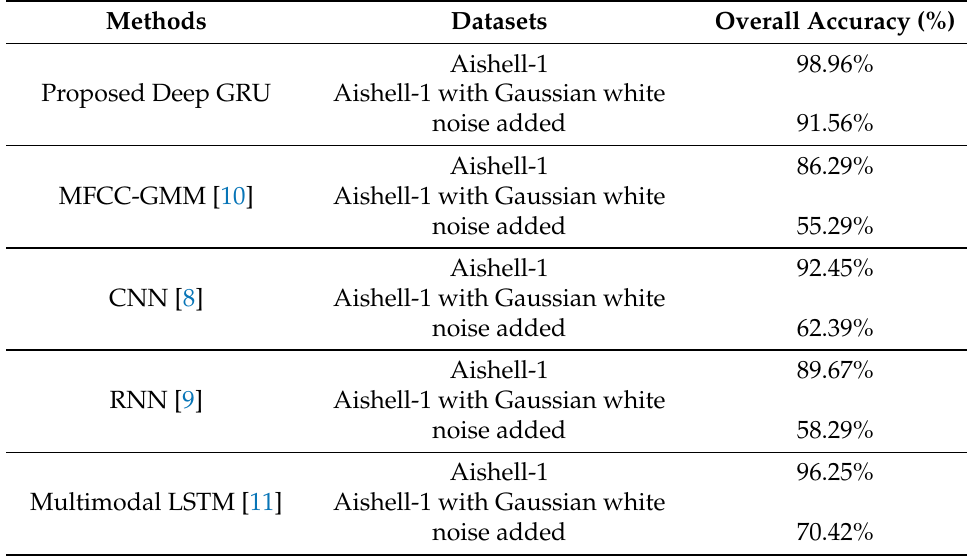
Table 3. Performance comparison with several existing